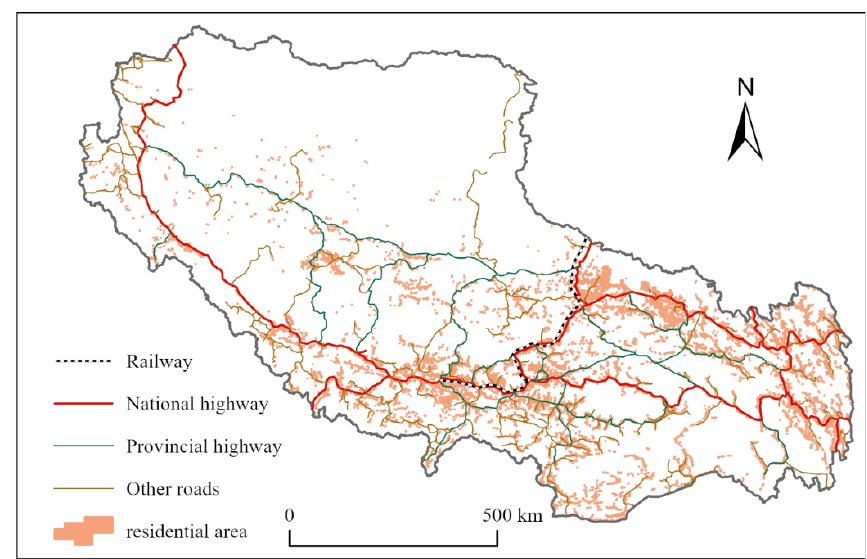
Figure 4. Spatial location map of Tibetan residential area and road network.